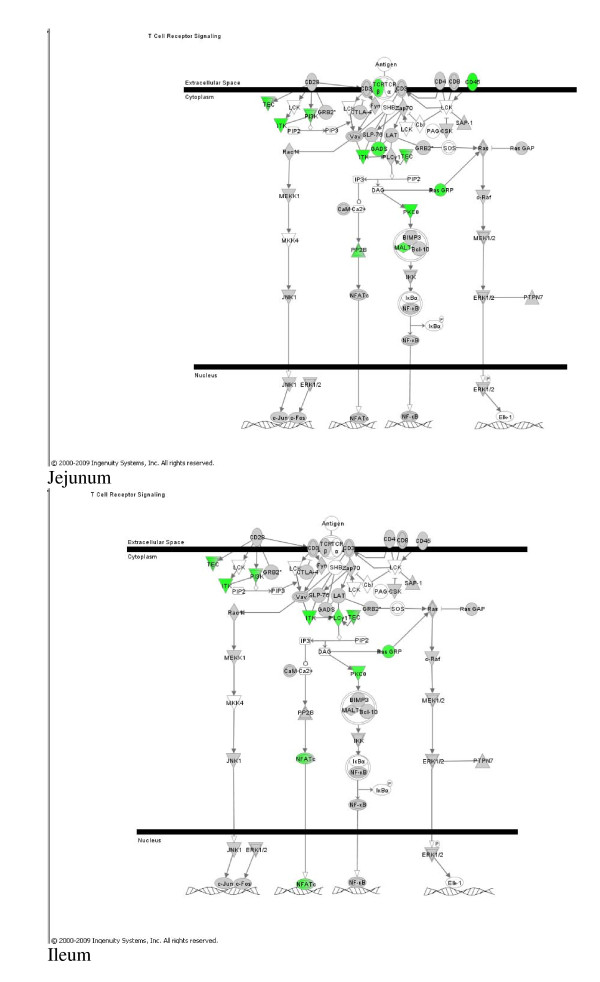
T-cell signaling in lactating jejunum and ileum. Downregulation of T-cell signaling in the jejunum (top, p = 1.68 × 10-7) and ileum (bottom, p = 4.7 × 10-4). Green shading indicates downregulation of the corresponding gene during lactation.